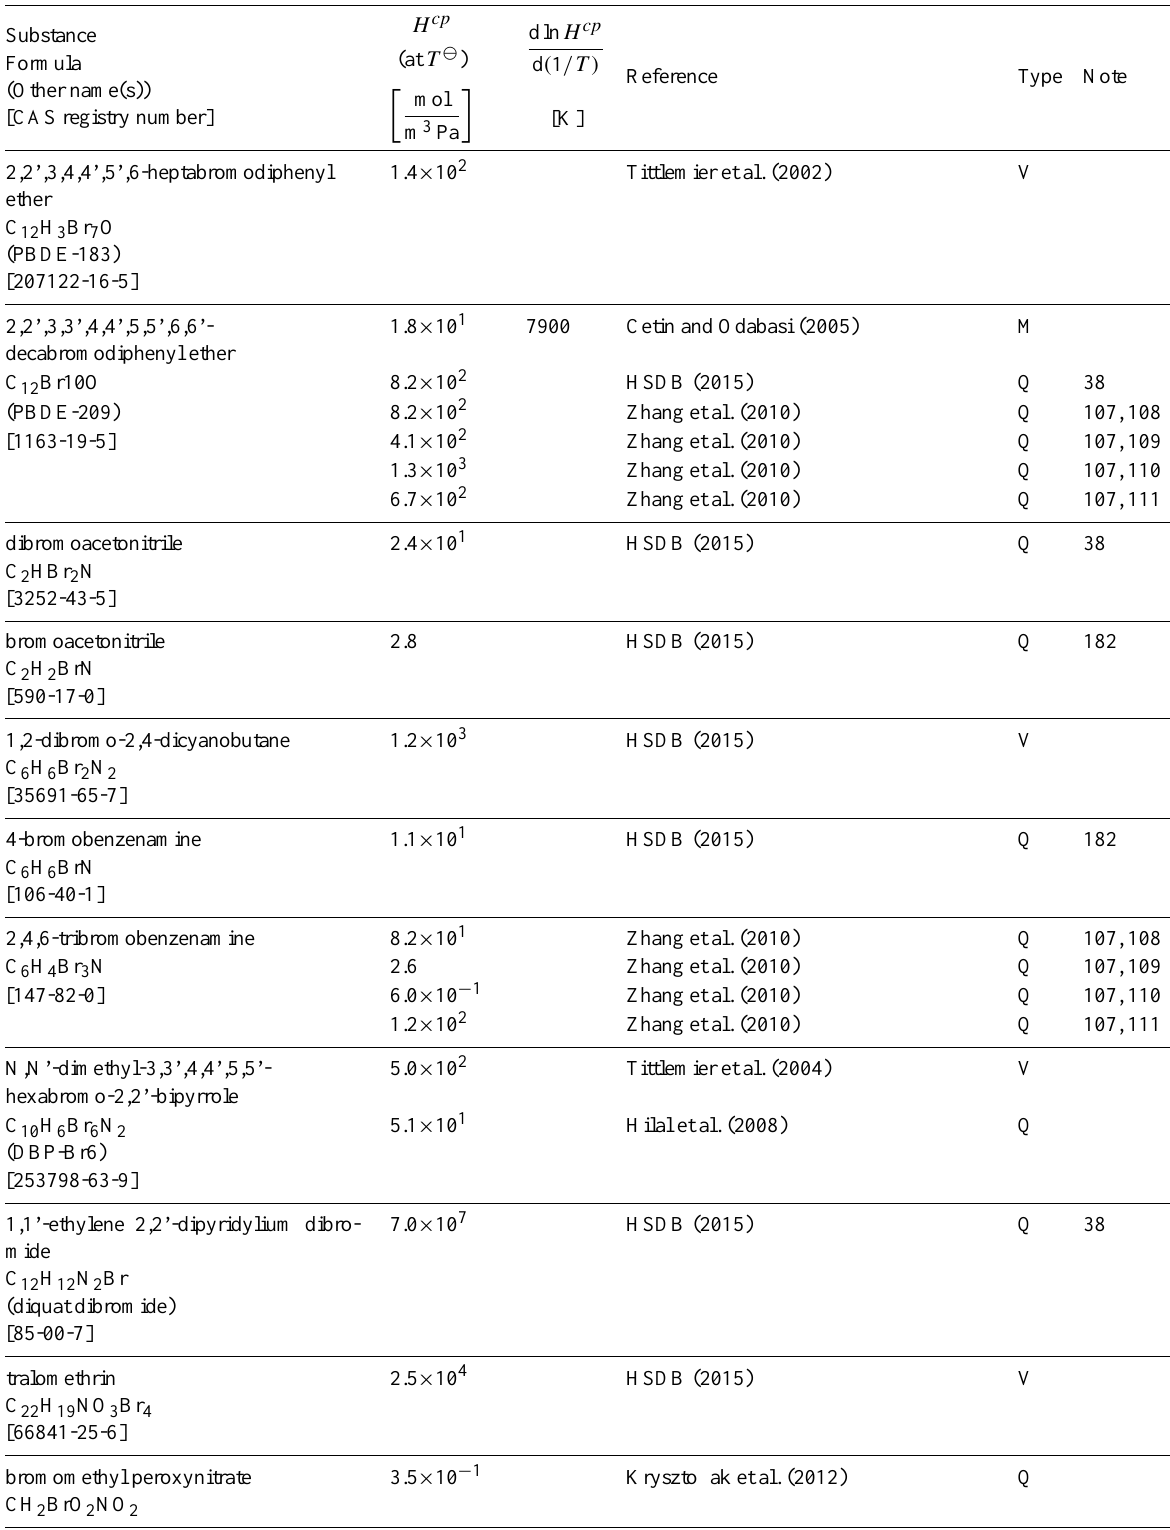
Table 6: Henry’s law constants for water as solvent